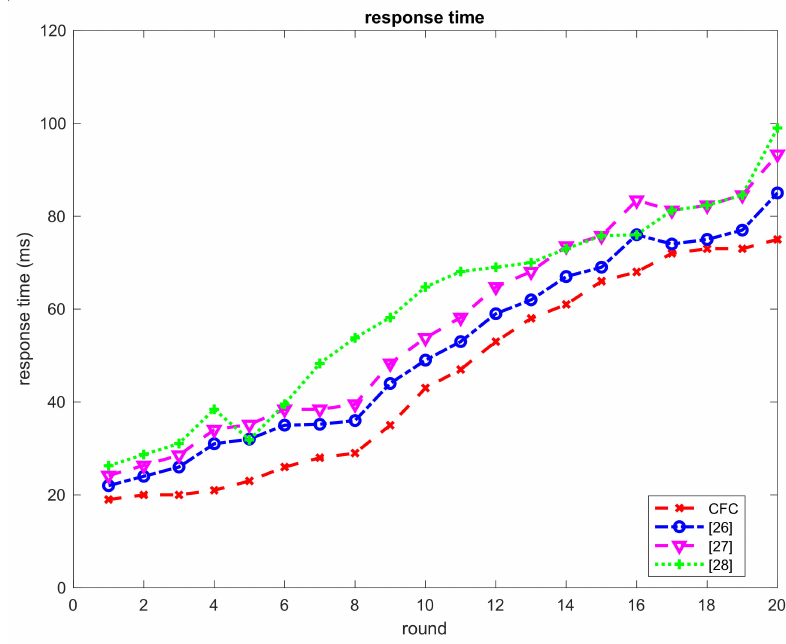
Figure 12. The response time of query for the newest